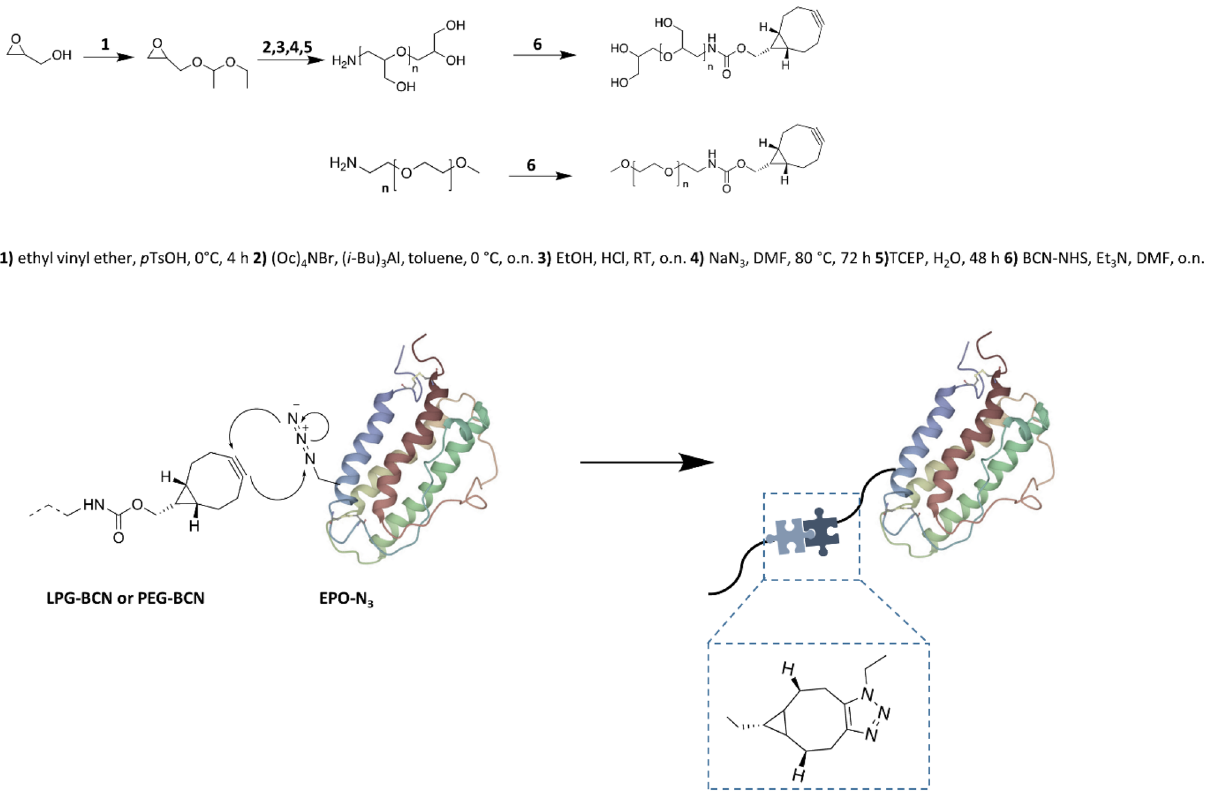
Figure 1. General scheme of the synthesis and chain-end modification of LPG and PEG with the following coupling to cell-free synthesized EPO. EPO structure obtained from PDB entry 1BUY 44